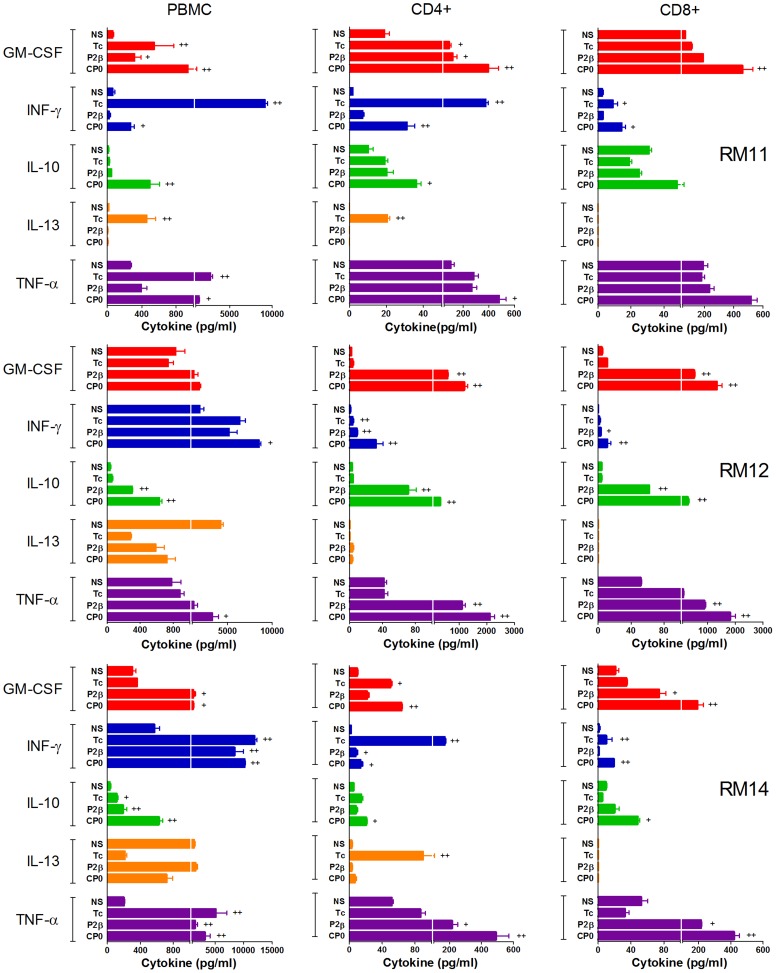
Cytokine production profile by CD4+ and CD8+ T cells derived from chagasic patients.CD4+ and CD8+ T cells from three chronic Chagas' disease Cardiomyopathy patients, called RM11, RM12 and RM14, were isolated as described under Methods. Enriched CD4+ or CD8+ T cells were co-cultured with the autologous CD3(neg) fraction as antigen presenting cells and the indicated stimulus. Supernatants were collected on day 6 and cytokines quantified by multiplex technology. For comparison, results from whole PBMC from each of the patients are represented in the left panel. Symbol (+) indicates a fold induction between 3 to 5 and (++) a fold induction>5. The fold induction was calculated as: [(cytokine in stimulated culture) - (cytokine in NS culture)]/(cytokine in NS culture), where NS denotes non-stimulated cells.